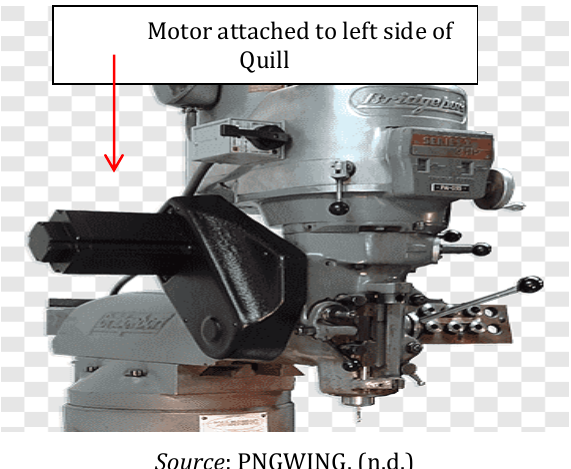
Figure 3: Rotary Actuator to Quill based Z-axis Movement, left side attachment